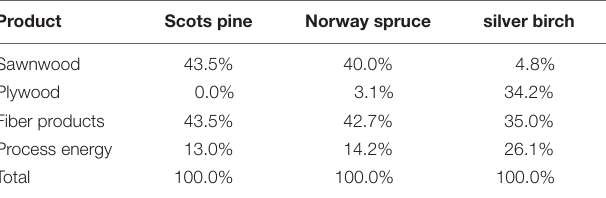
TABLE 1 | Shares of products when processing